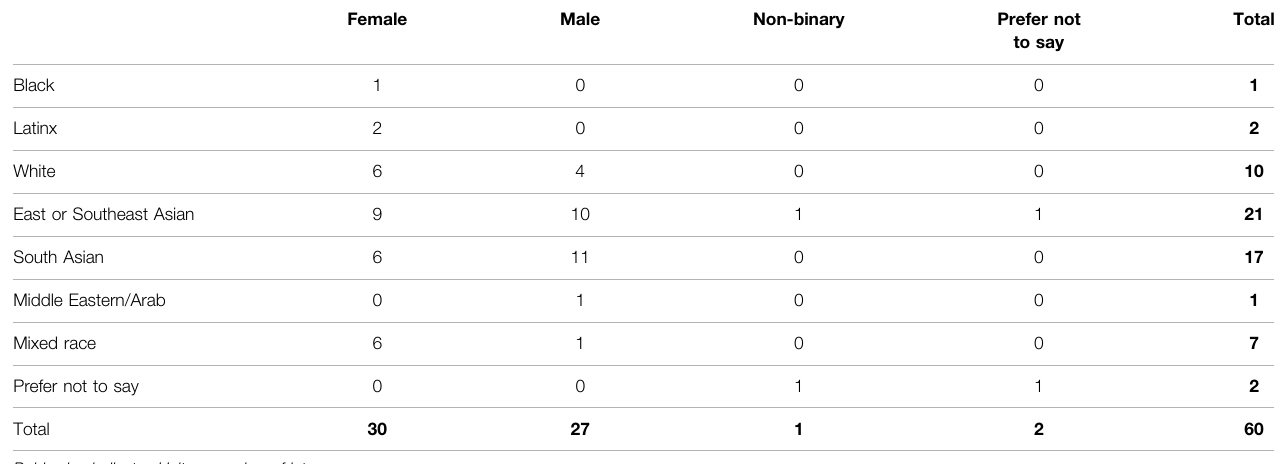
TABLE 1 | The demographics (race and gender) of the summer 2020 Mosquito Mappers interns who provided knowledge quiz and survey responses. Female